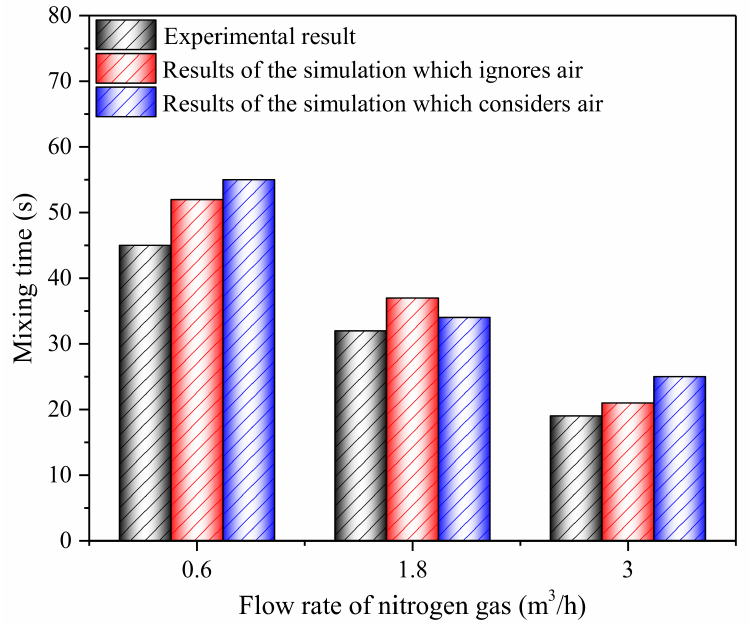
Figure 4. Mixing times of experiment, the simulation that ignored the air, and the simulation that considered the air of the model ladle with four side plugs at 116 mm under different flow